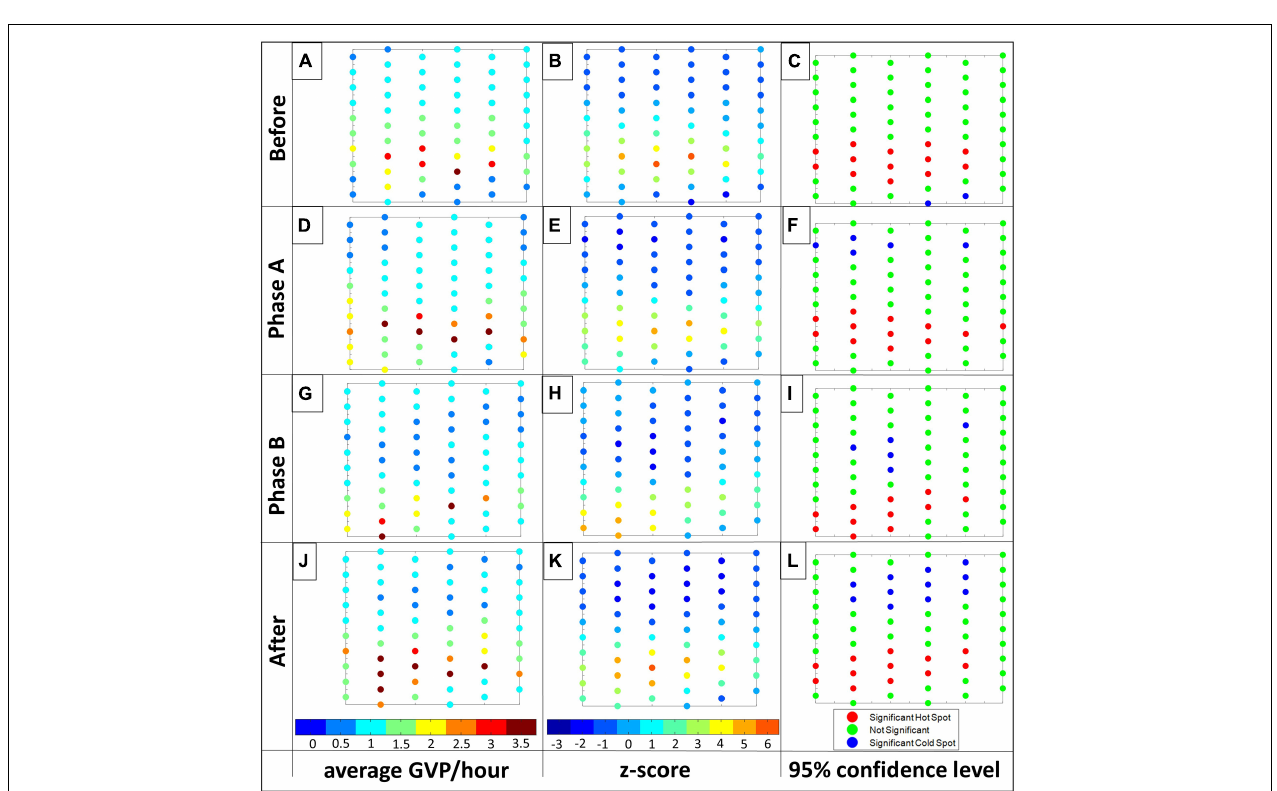
FIGURE 9 | Visualization of the Gi* results for the PMRF exemplar: Before, Phase A, Phase B, and After, from top row to bottom row, respectively. From left column to right: (1) the average GVP/ hour standardized to total time where the colorbar ranges from 0 (dark blue) to 3.5 (red) GVP/hour the Gi* z -value with colorbar ranging from –3 (dark blue) to 6 (red), and 3) hot (red) and cold spots (blue) at a 95% confidence level. For ease in displaying, individual hydrophone values were rounded to the closest number on the color bar for columns one and two. Letters associated with each plot are used for ease in referencing individual plots in the